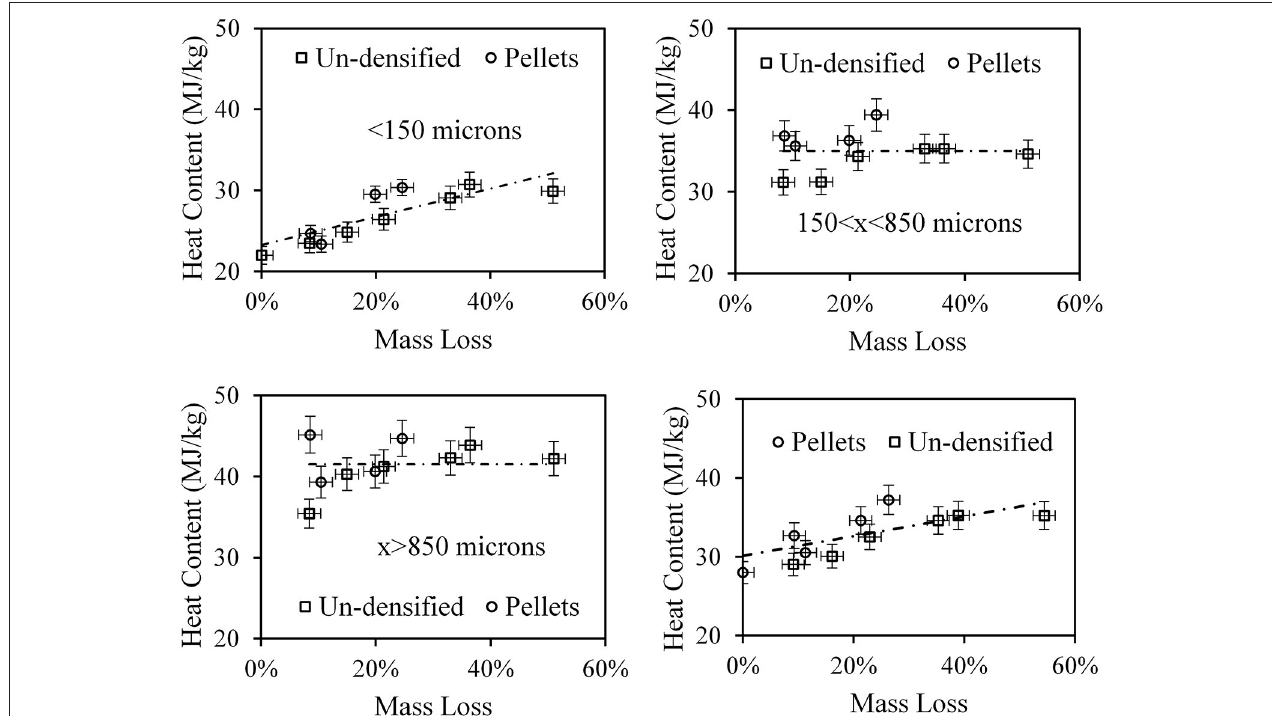
FIGURE 11 | Top left. Heat content of the size fraction x < 150 µ m. Top right, same for 150 < x < 850 µ m. Bottom left. Same for x > 850 µ m. Bottom right. Total heat content.